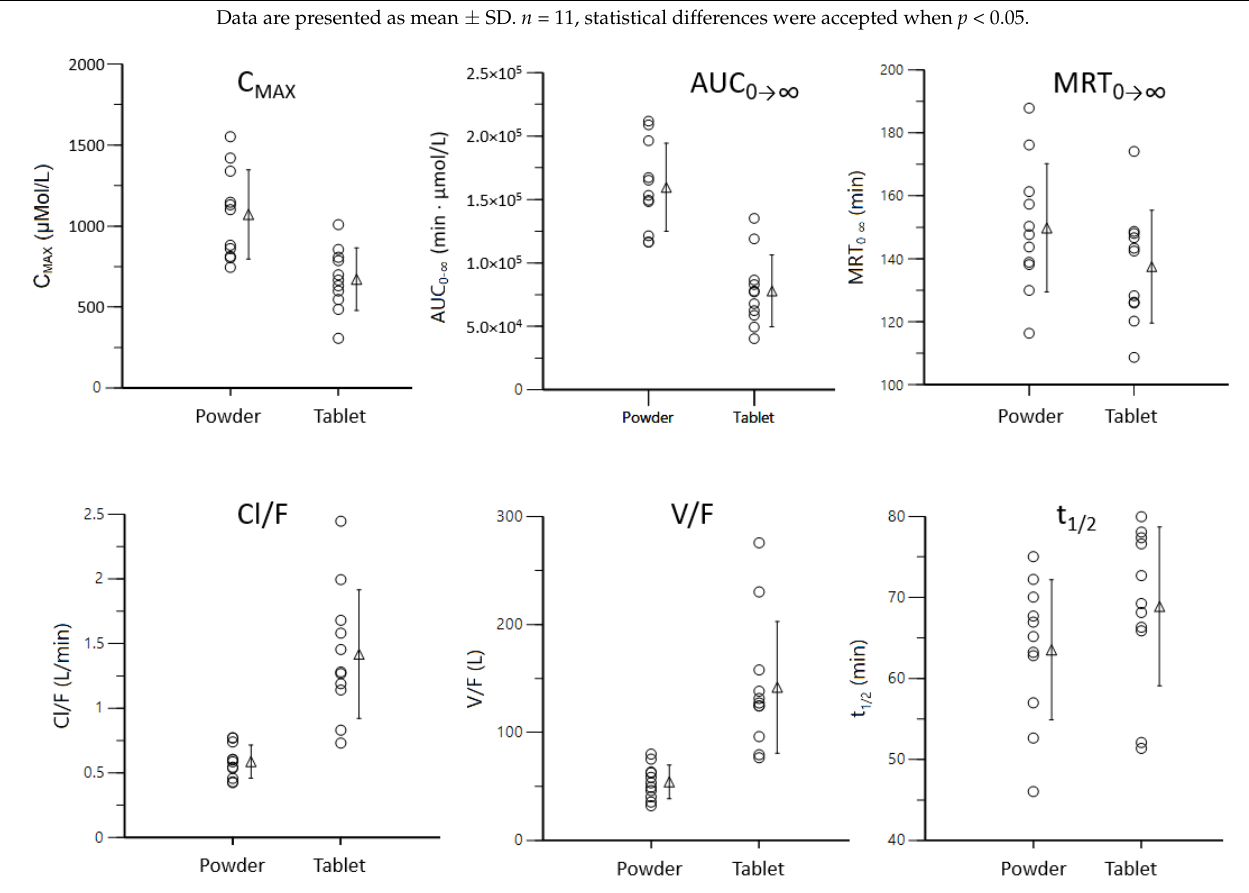
Table 1. Non-compartmental pharmacokinetic parameters of the test and reference formulations.